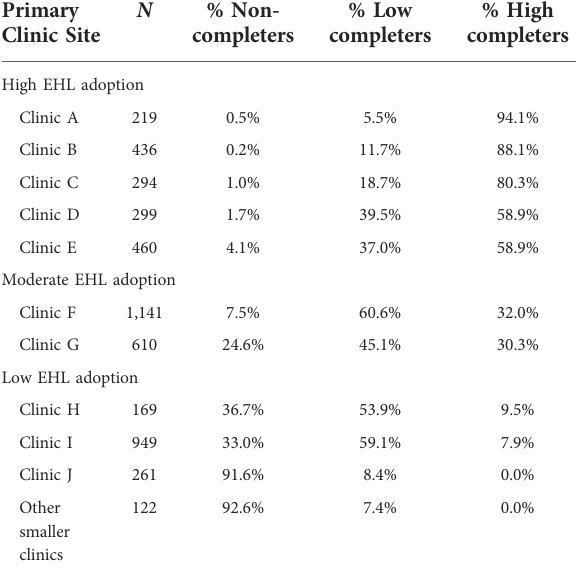
TABLE 2 Primary clinic sites by EHL adoption category with the proportion of individuals in each completer group.